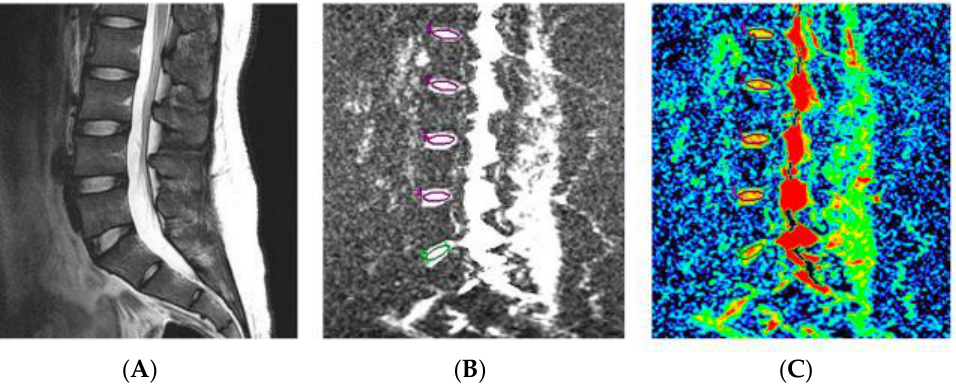
Figure 5. Diffusion-weighted image (DWI) and apparent diffusion coefficient (ADC) mapping image (reused from [61] ). ( A ) T2WI; ( B ) DWI; ( C ) ADC mapping image.